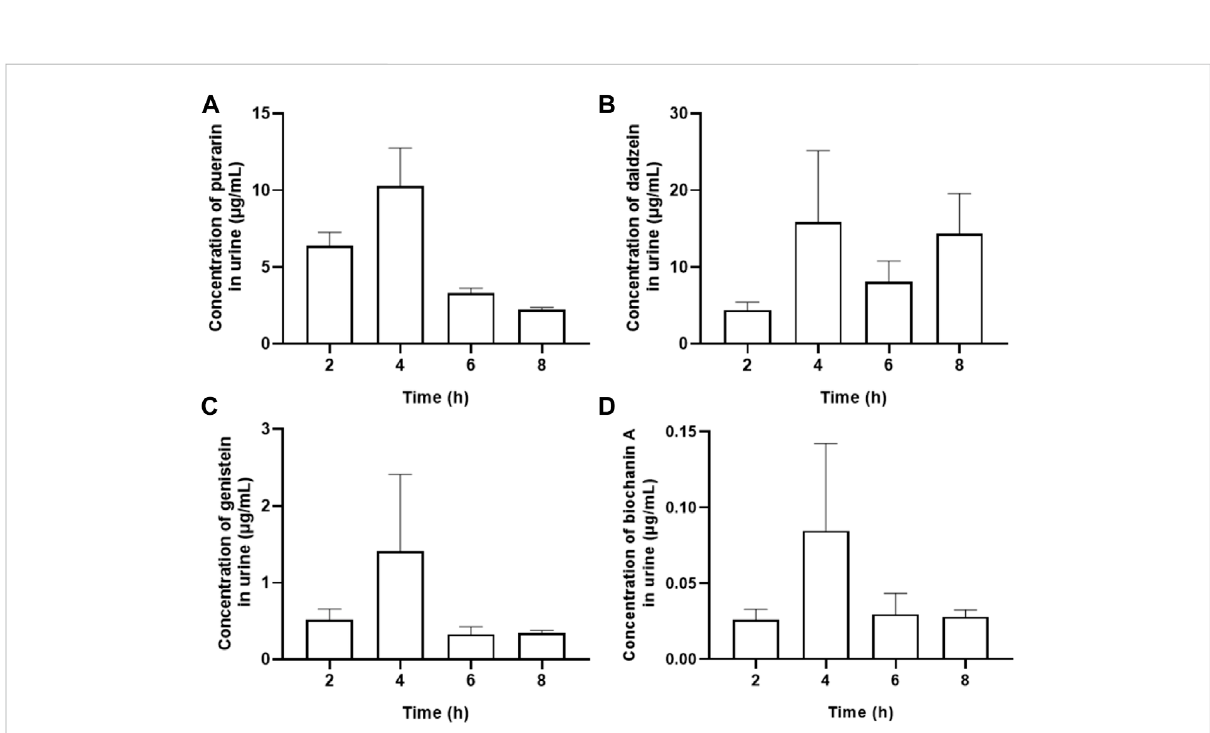
FIGURE 4 Contents of major urine metabolites including peurarin (A) , daidzein (B) , genistein (C) and biochanin A (D) after oral administration of Gegen water extract in SHR as detected by LC-MS/MS (Mean ± SEM; n =